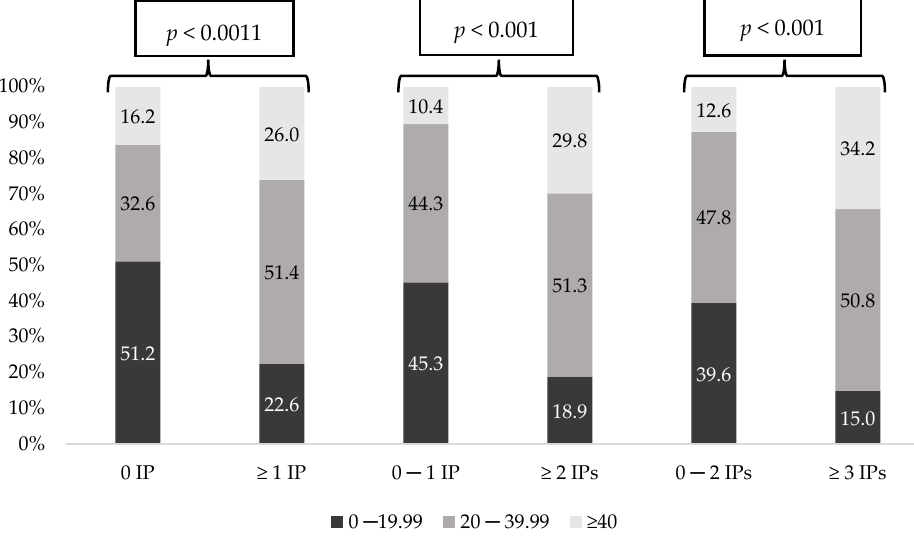
Figure 3. Prevalence of polypharmacy degree considering number of Inappropriate Prescriptions (IPs).